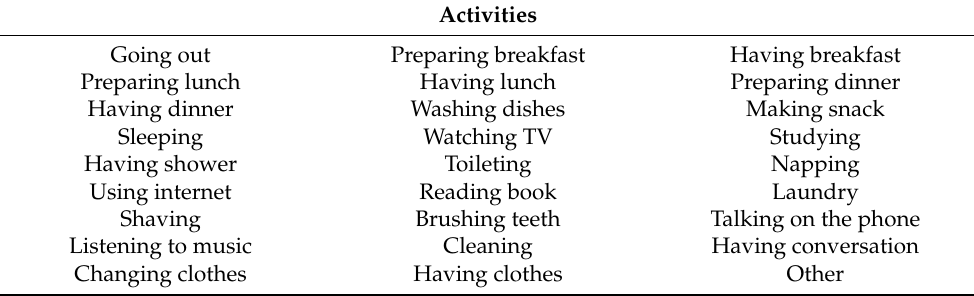
Table 2. Activities available in the ARAS